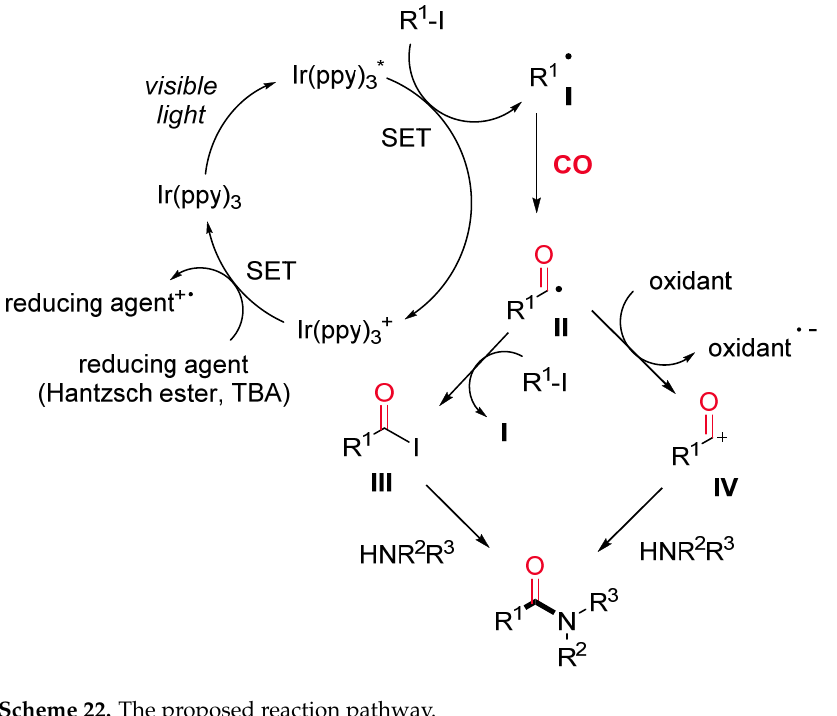
Scheme 22. The proposed reaction pathway.